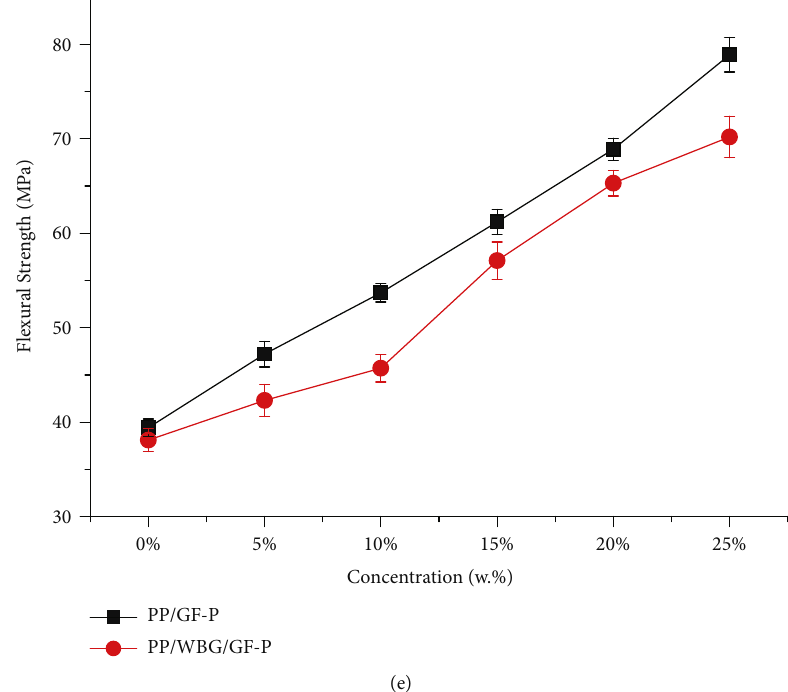
Figure 7: The tensile strength, fl exural modulus, impact strength, tensile modulus, and fl exible strength versus glass fi ber power wt% concentration. The concentration of β -NA is fi xed at 0.2%.